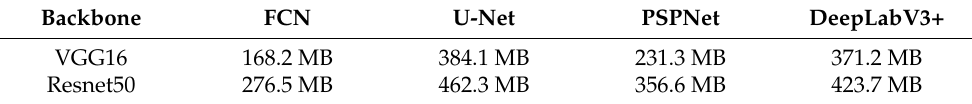
Table 5. Weight file of models.